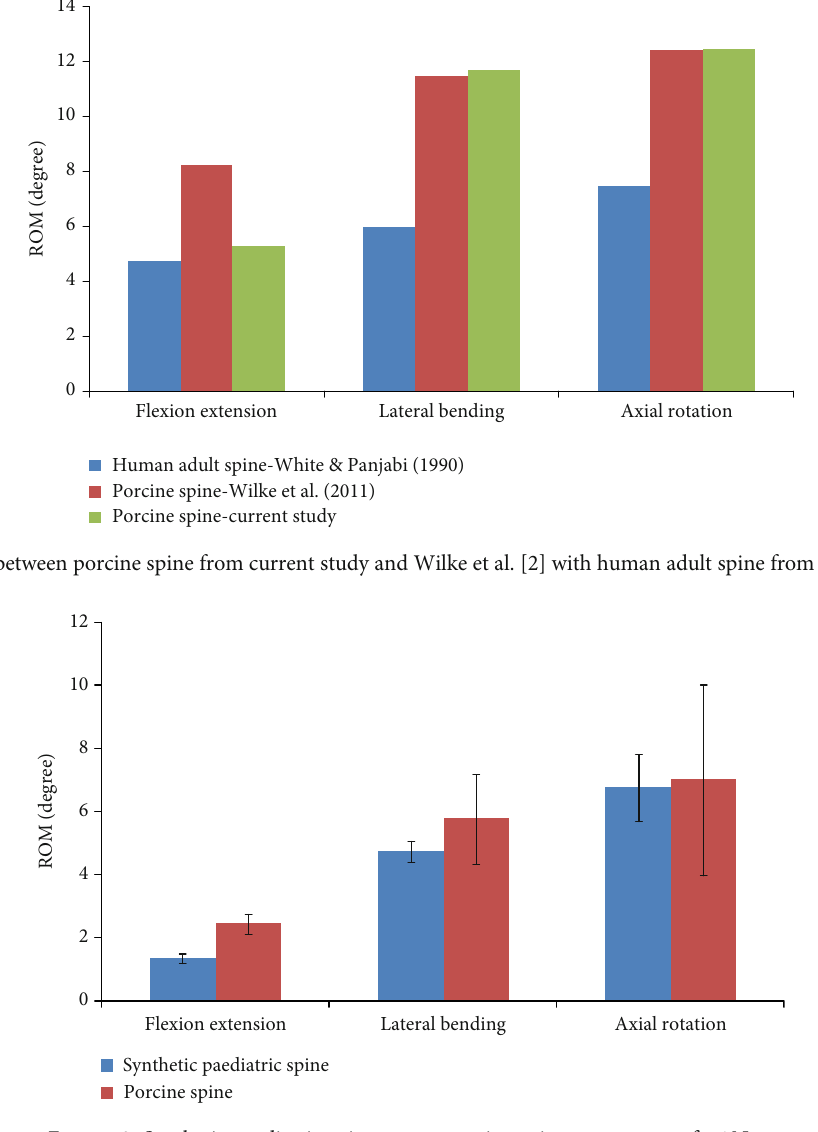
Figure 8: Synthetic paediatric spine versus porcine spine at moment of ± 4